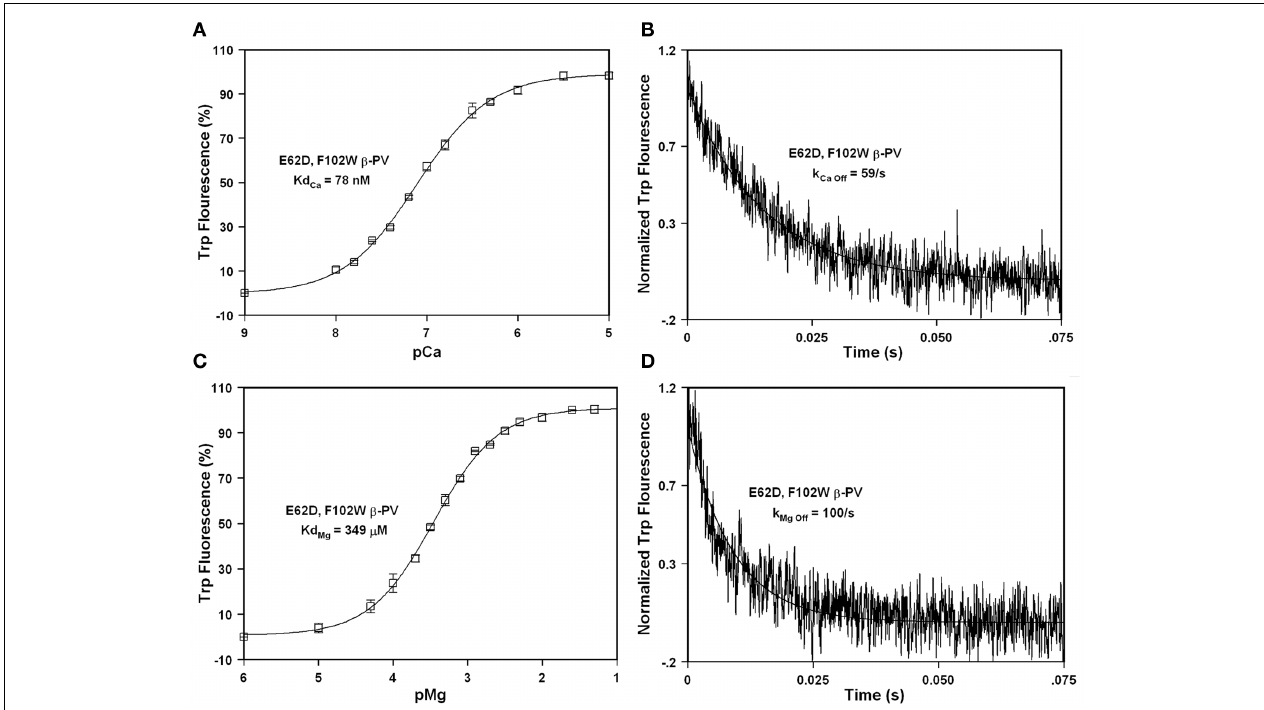
FIGURE 5 | Ca 2 + and Mg 2 + binding and dissociation from E62D, F102W β -PV. (A) The Ca 2 + dependent increase inTrp fluorescence is shown as a function of − Log[Ca 2 + ] (pCa) for E62D, F102W β -PV. (B) The time course ofTrp fluorescence is shown as EDTA rapidly chelates Ca 2 + causing dissociation of Ca 2 + from E62D, F102W β -PV. (C) The Mg 2 + dependent increase inTrp